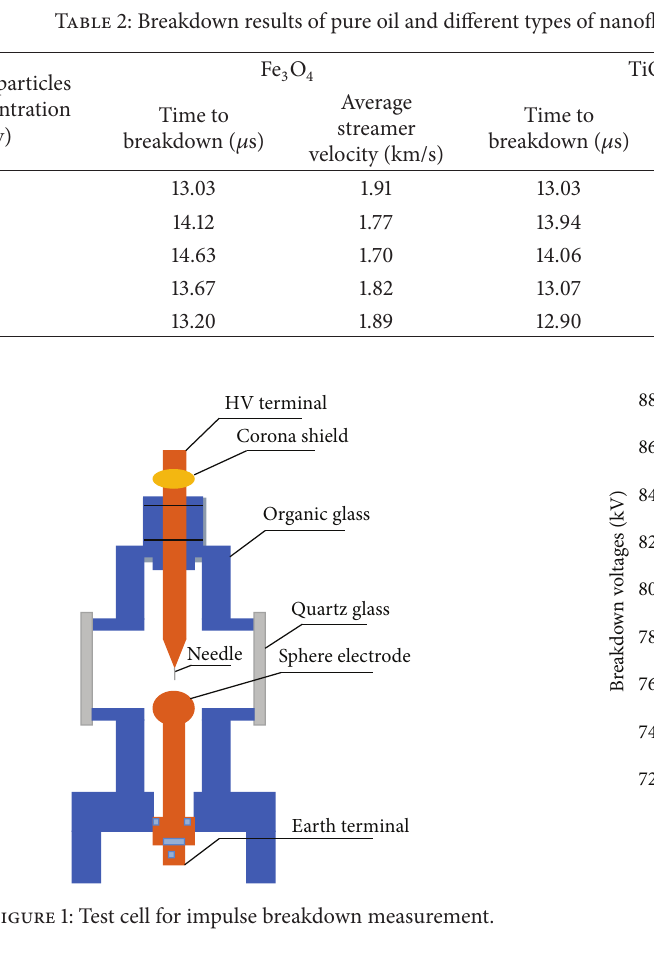
Figure 2: Positive impulse breakdown voltages of different nanoflu- ids with different concentrations (25 mm gap